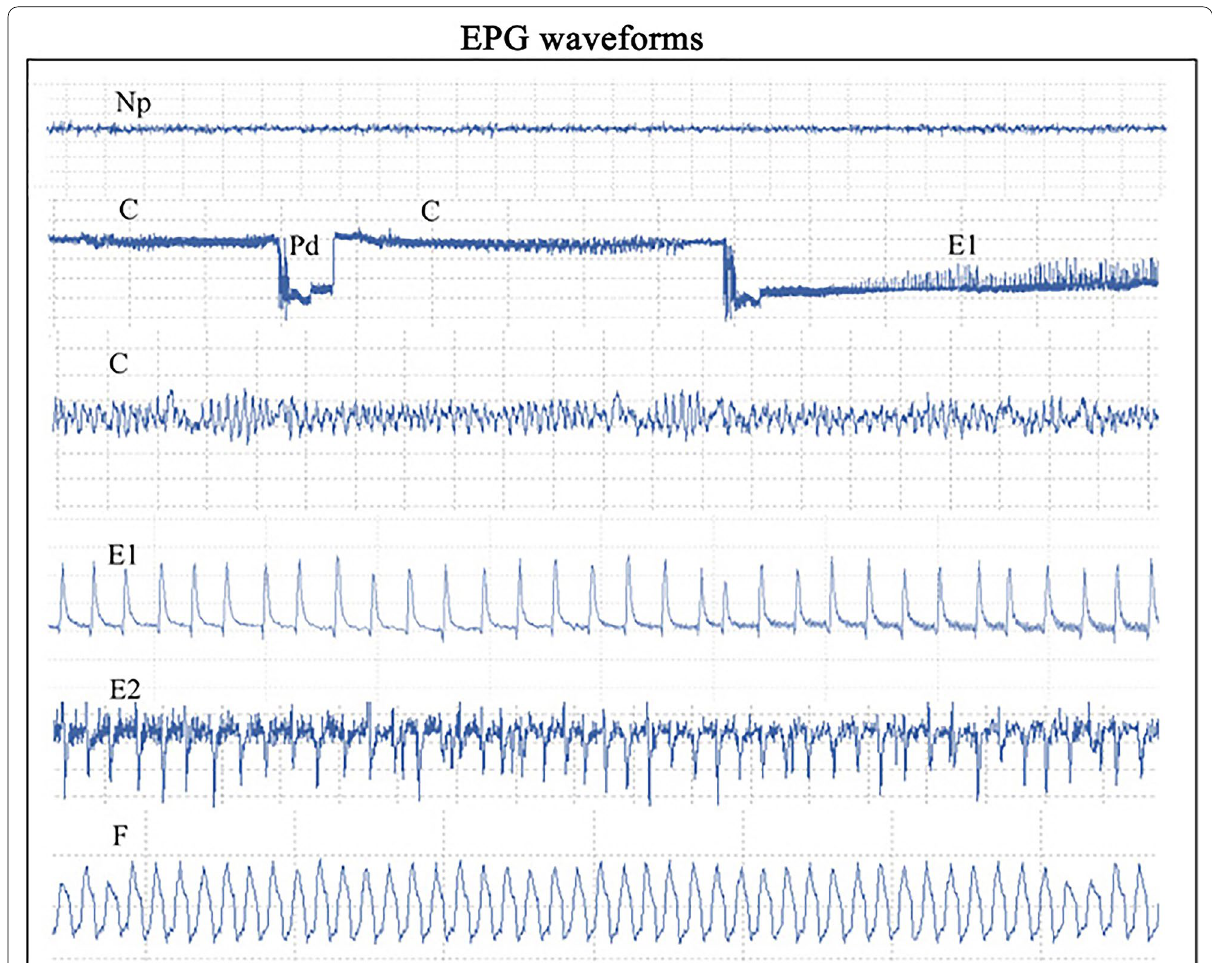
Fig. 3 Six basic EPG waveform maps of male cotton aphid feeding on cotton. Np (non-penetration) waveform appears due to stylet withdrawal; waveform C (the probing period waveform consists of aphid mouth needles probing between mesophyll cells or outside the sieve molecules in phloem); Pd (potential drops, the aphid’s mouth needles probe inside the living cells); F (the aphid mouth needles encounter mechanical resistance outside the plant tissues and cells); E1 (the aphids’ mouth needles secrete saliva into the sieve elements); 6) E2 (the aphid mouth needles feed